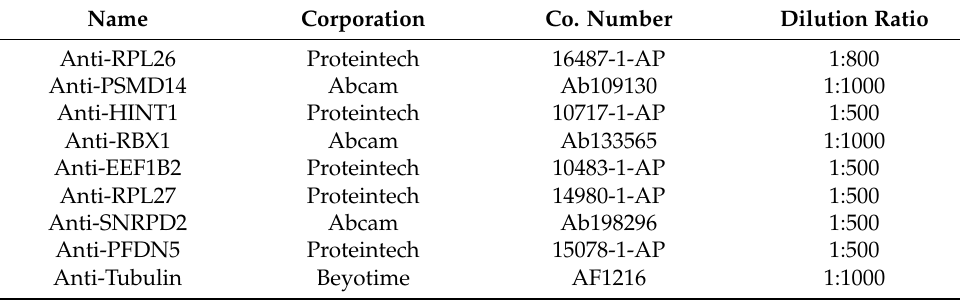
Table 2. The information of the primary antibodies used in this